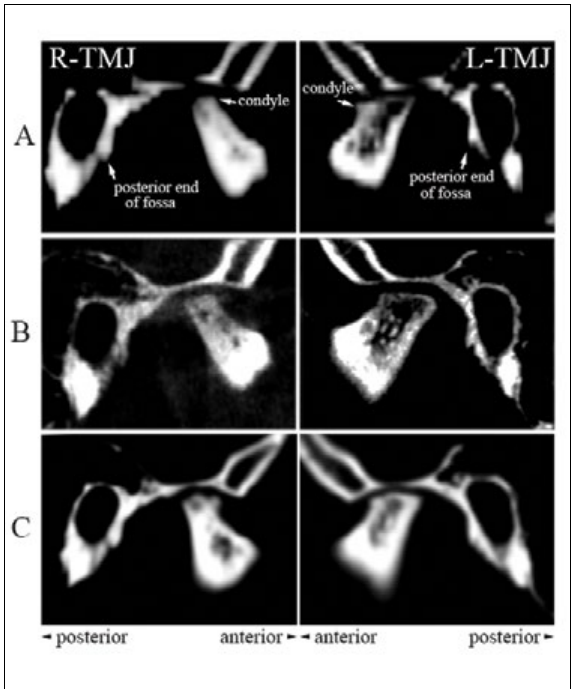
Figure 2. Sagittal CT images of the TMJ (A) pretreatment; (B) post-active treatment; (C) post-five-year